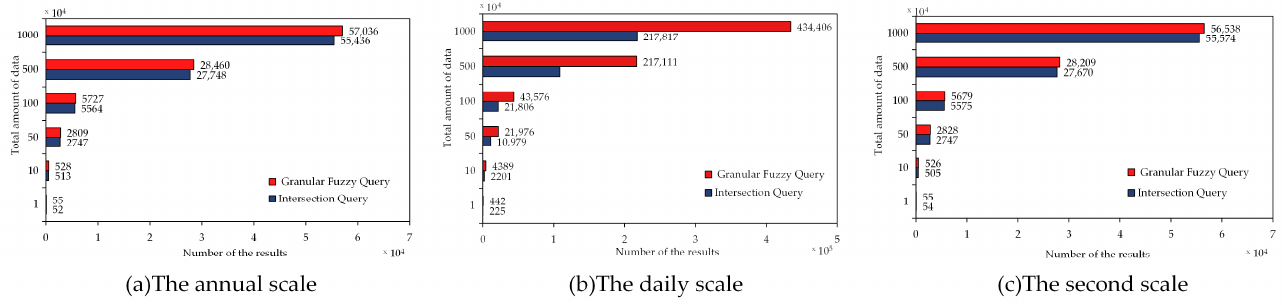
Figure 8. The number of query results for both methods. ( a ) the number of query results for the annual scale query interval. ( b ) the number of query results for the daily scale query interval. ( c ) the number of query results for the second scale query interval.